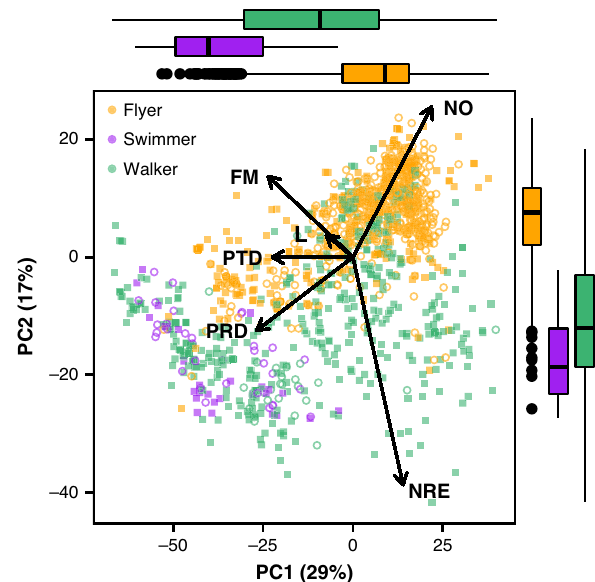
Fig. 2 Phylogenetically corrected PCA of size-corrected life-history traits. Colours correspond to locomotory mode ( fl yers = orange; swimmers = purple; walkers = green; n = 1296 species). Solid squares represent the position of non-migratory species along the PC1 (fast – slow continuum) and PC2 (reproductive strategy) and open circles represent the position of migratory species. Arrow length indicates the eigenvectors of each size- corrected life-history trait onto PCA axes. Boxplots on the top and right represent median, upper and lower quartiles of PC1 and PC2 depending on the locomotion mode. NO = number of offspring in each reproductive event; FM = age of female sexual maturity; L = longevity, PTD = duration of postnatal development; PRD = duration of prenatal development; NRE = number of annual reproductive